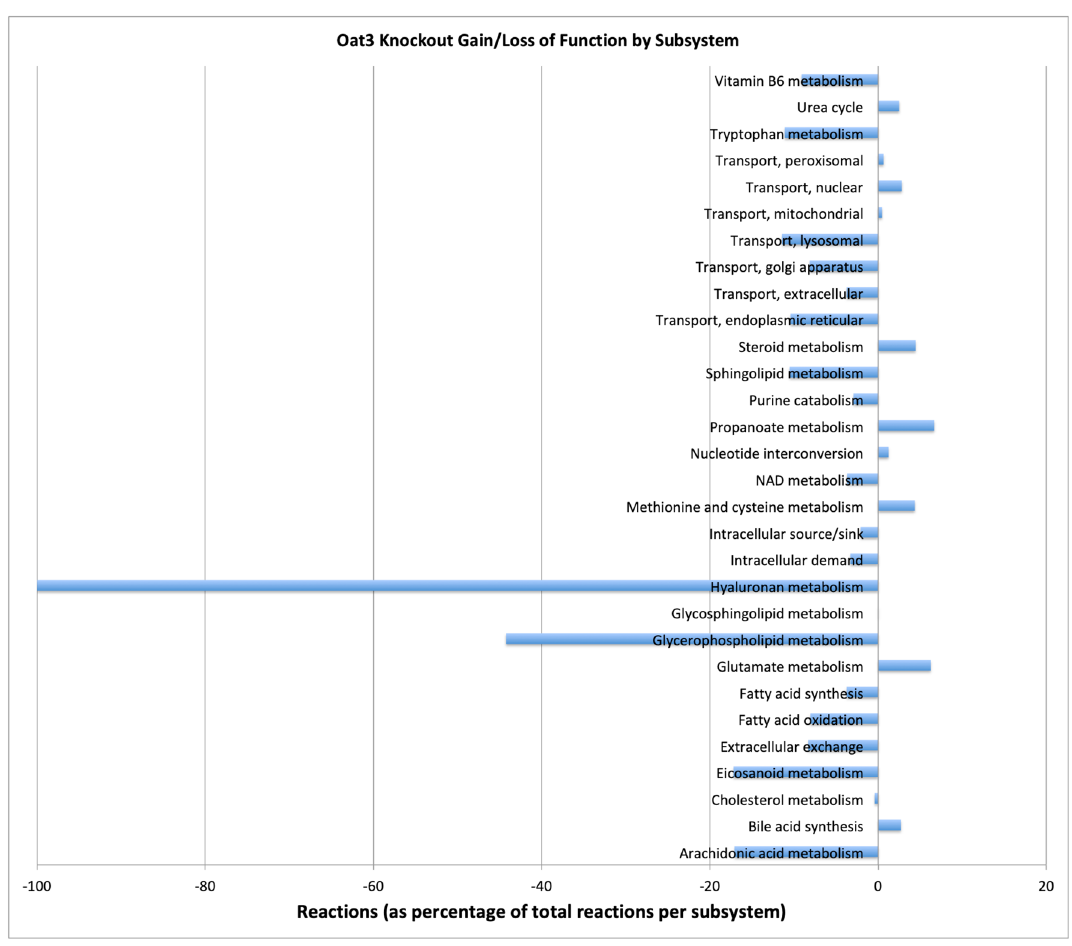
Figure 5. Changes in mutually exclusive reactions in the WT versus OAT3 KO models according to metabolic sub-systems given as a percentage of the total number of reactions present in each Recon3D sub-system. In the Oat3KO model, notable decreases are seen in hyaluronan and glycerophospholipid metabolism. It is important to also recognize that, even though the number of reactions in a particular sub-system may decrease, particular reactions within that sub-system may have an increase in mean flux (since anabolic and catabolic reactions may be grouped within a single